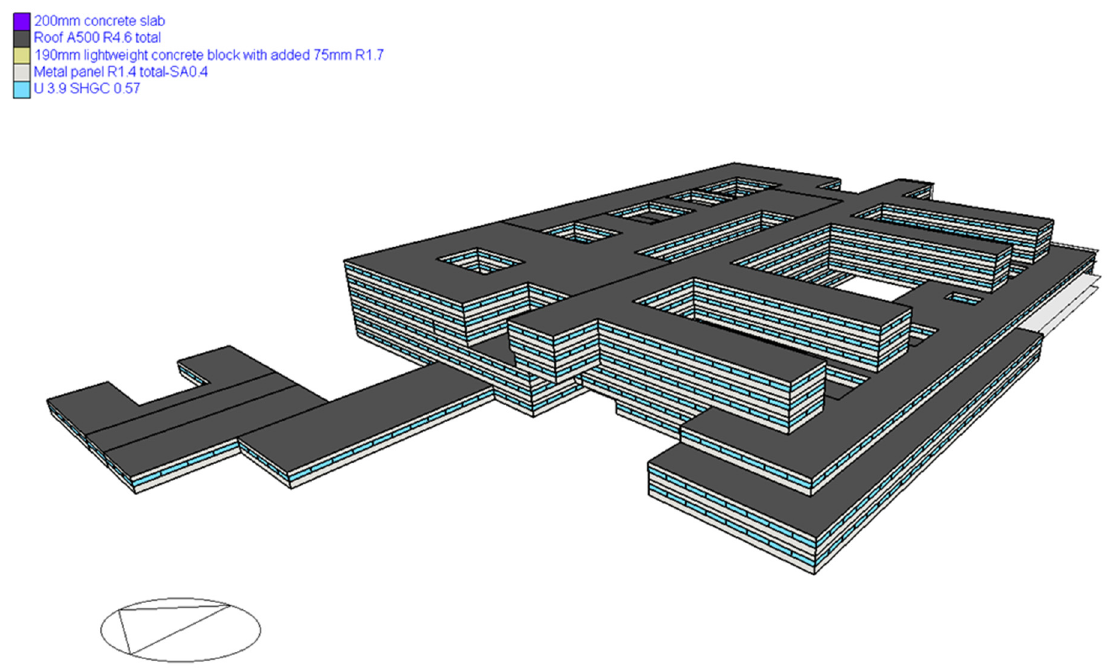
Figure 5. Large hospital building model.